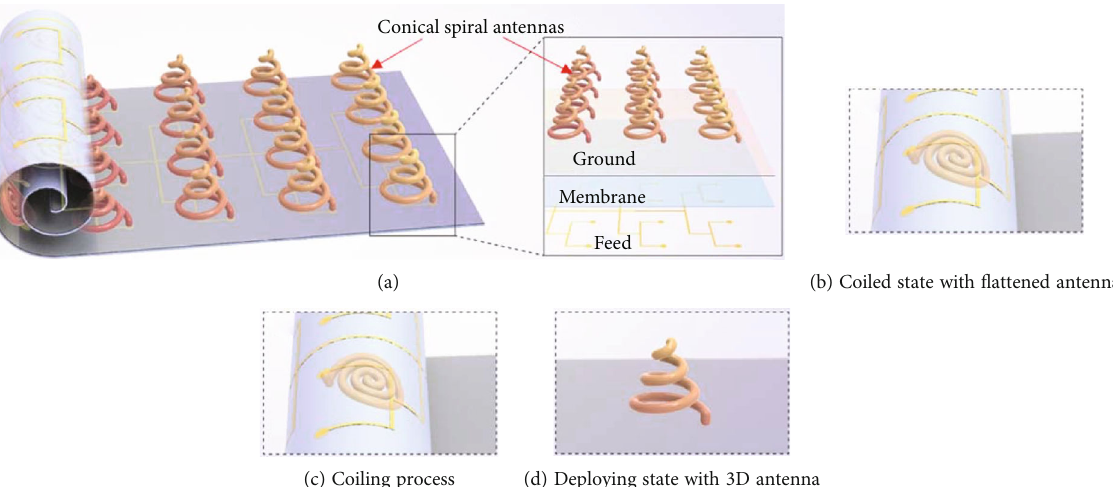
Figure 1: Schematic illustration of fl exible coilable antenna array with conical spiral